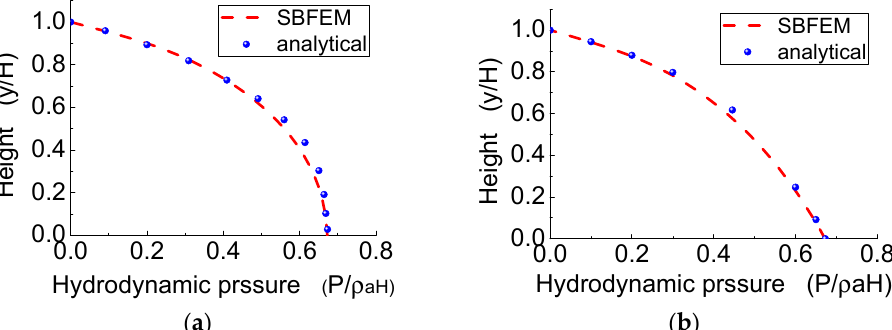
Figure 16. Semi-circular valley with upstream–downstream excitation: ( a ) along line AB and ( b ) along line BC.